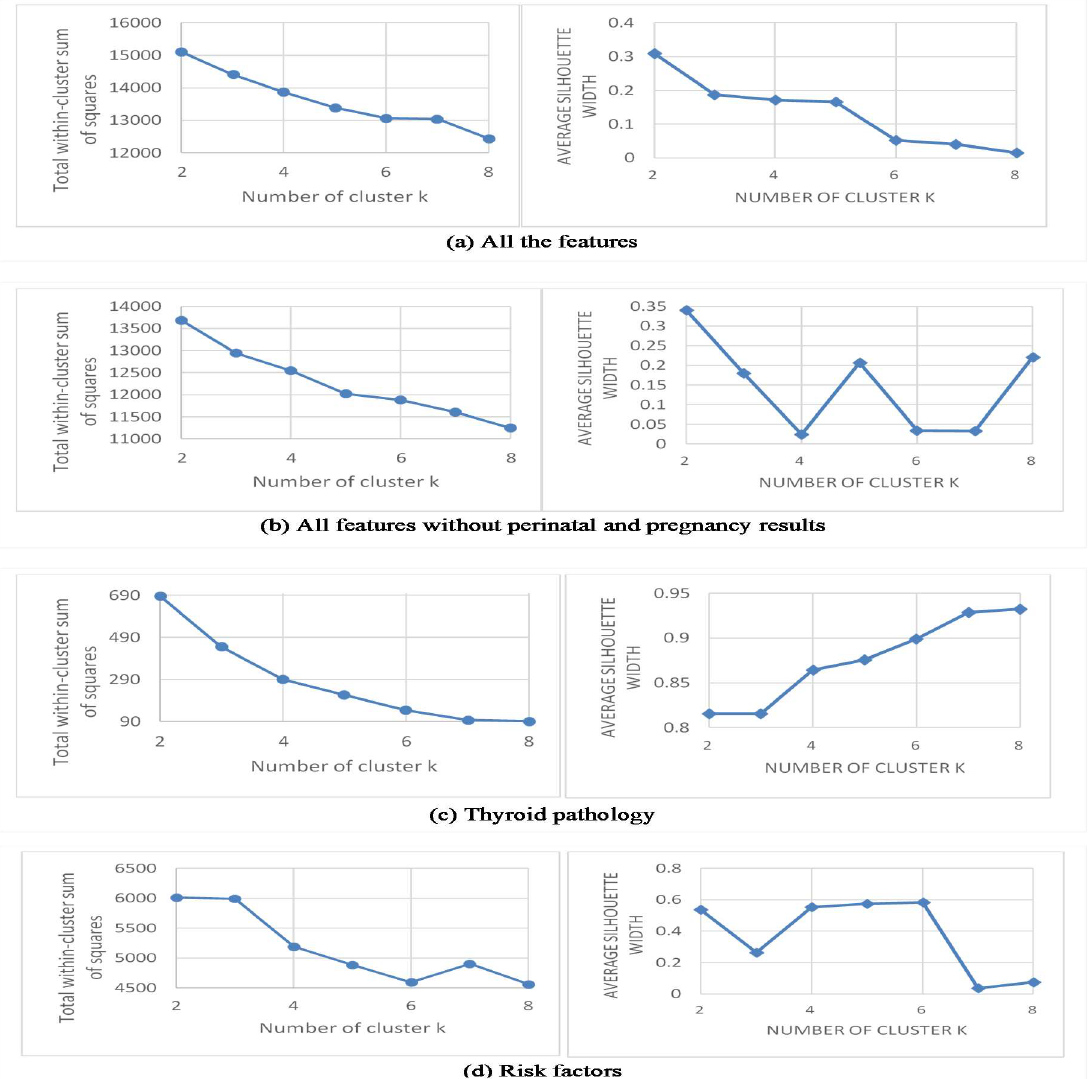
Figure 1. Elbow method and the average silhouette.